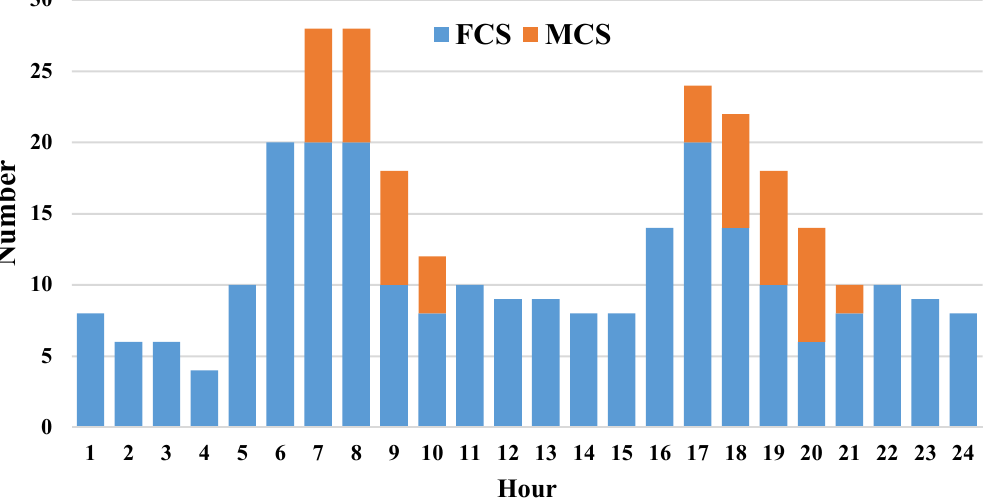
Figure 7. Number of under charging EVs in MCS and FCS.